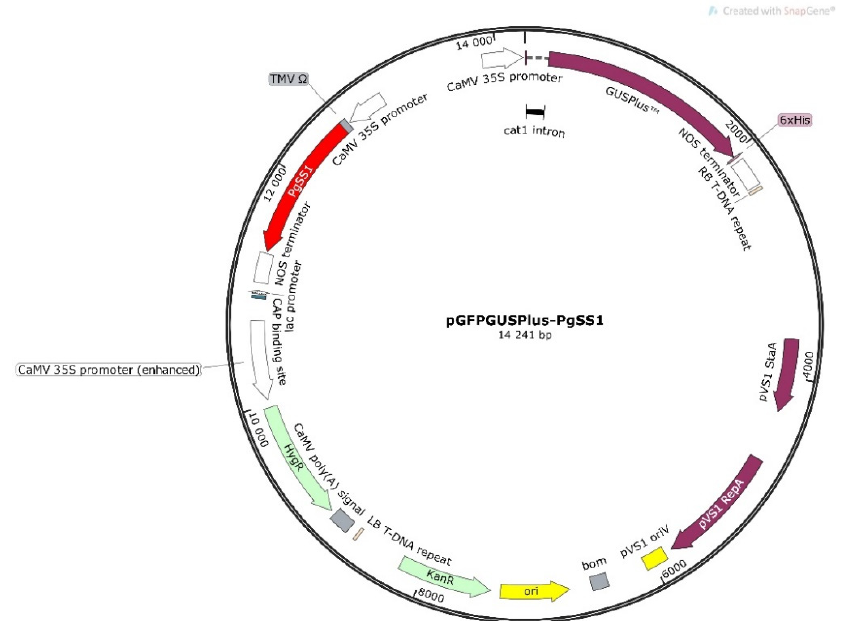
Figure 1. Schematic representation of the recombinant pGFPGUSPlus- Panax ginseng squalene synthase 1 (PgSS1) vector used in this study (SnapGene ® software (from GSL Biotech; available at